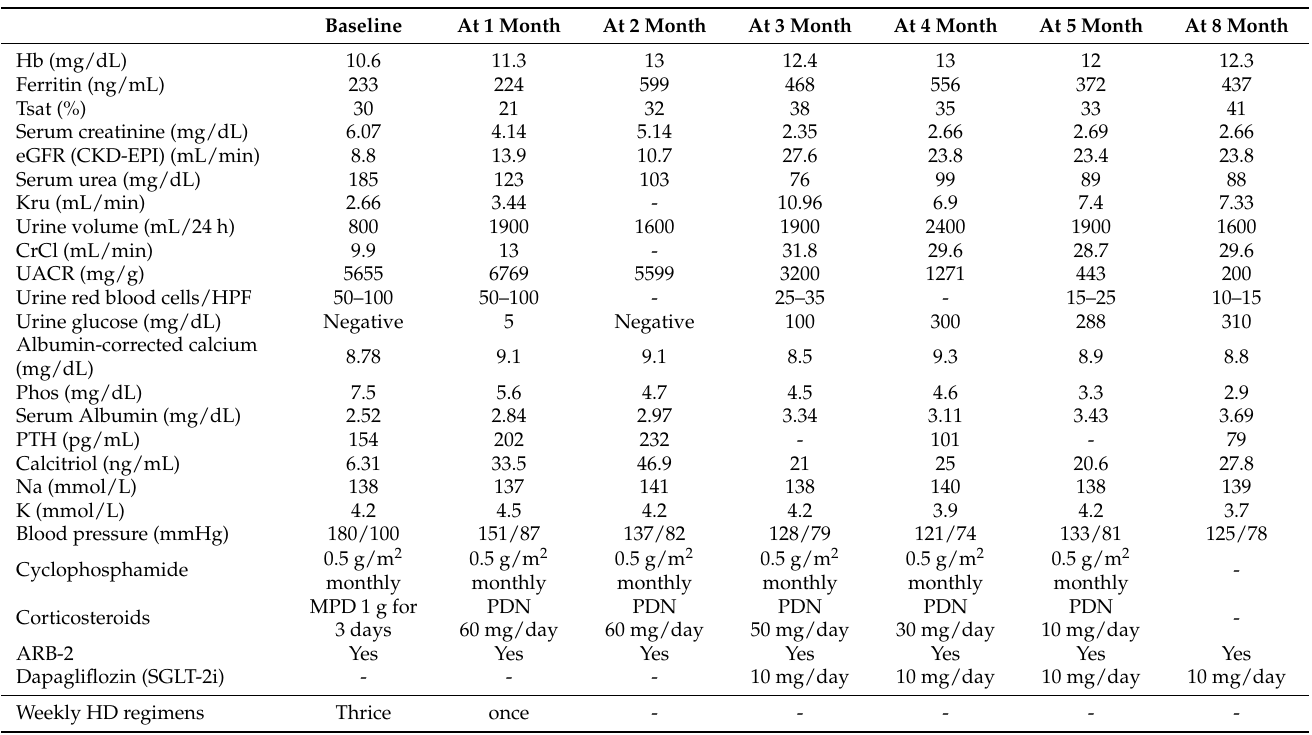
Table 2. Evolution of laboratory characteristics and renal function